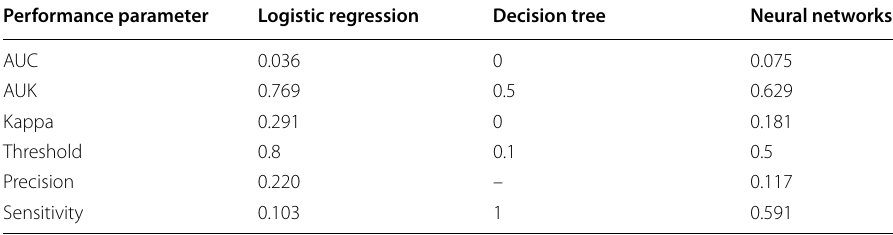
Table 5 Performance parameters for the models tested Performance parameter